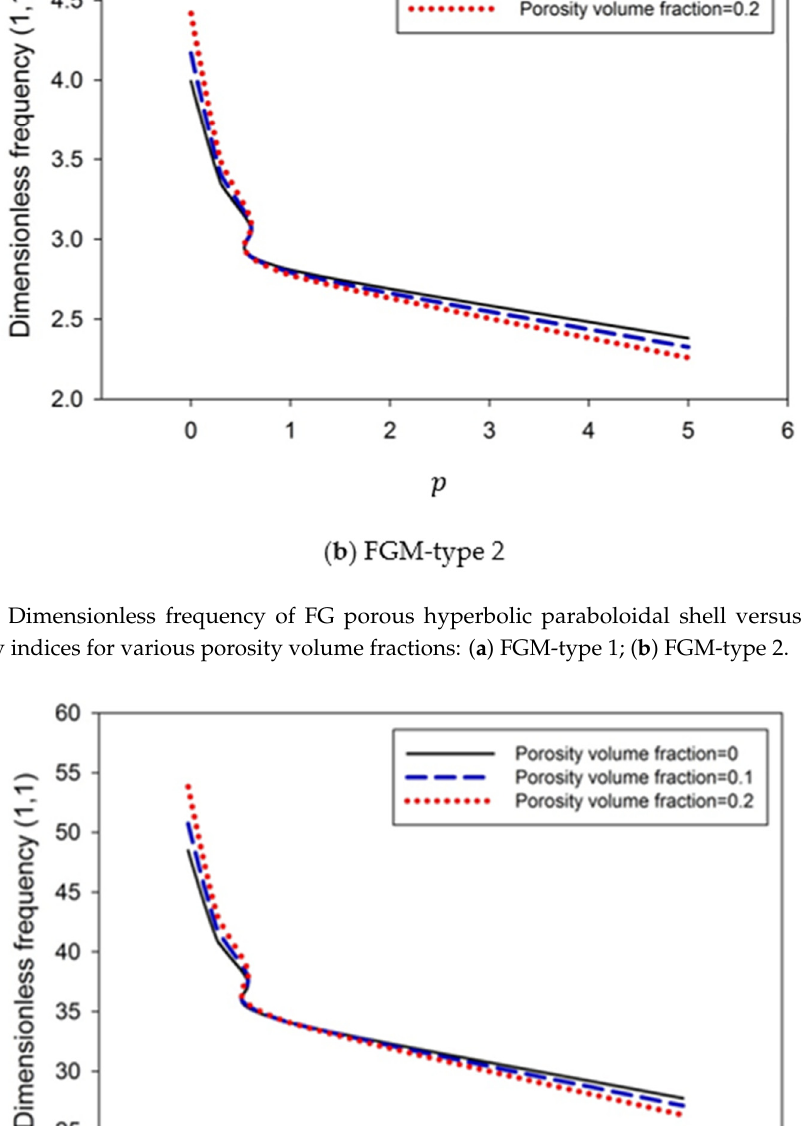
Figure 9. Dimensionless frequency of FG porous circular cylindrical shell versus different power ‐ law indices for various porosity volume fractions: ( a ) FGM ‐ type 1; ( b ) FGM ‐ type 2. 7. Conclusions The dynamic equilibrium equations of FG porous doubly ‐ curved shells have been derived by means of the Hamilton’s principle. FSDT is used to study the shell theory. FG shells with two various ceramic volume fraction distributions are considered, in the presence of an even distribution of porosities. Navier’s solution method is employed here to solve the equations of motion and a comparative study is performed to verify the accuracy of our results. We analyze the free vibration behavior of three special cases of FG doubly ‐ curved shells (spherical shell, hyperbolic paraboloidal shell, and circular cylindrical shell). All the results reveal that the porosity and a combined distribution of ceramic and metal during manufacturing can significantly affect the mechanical